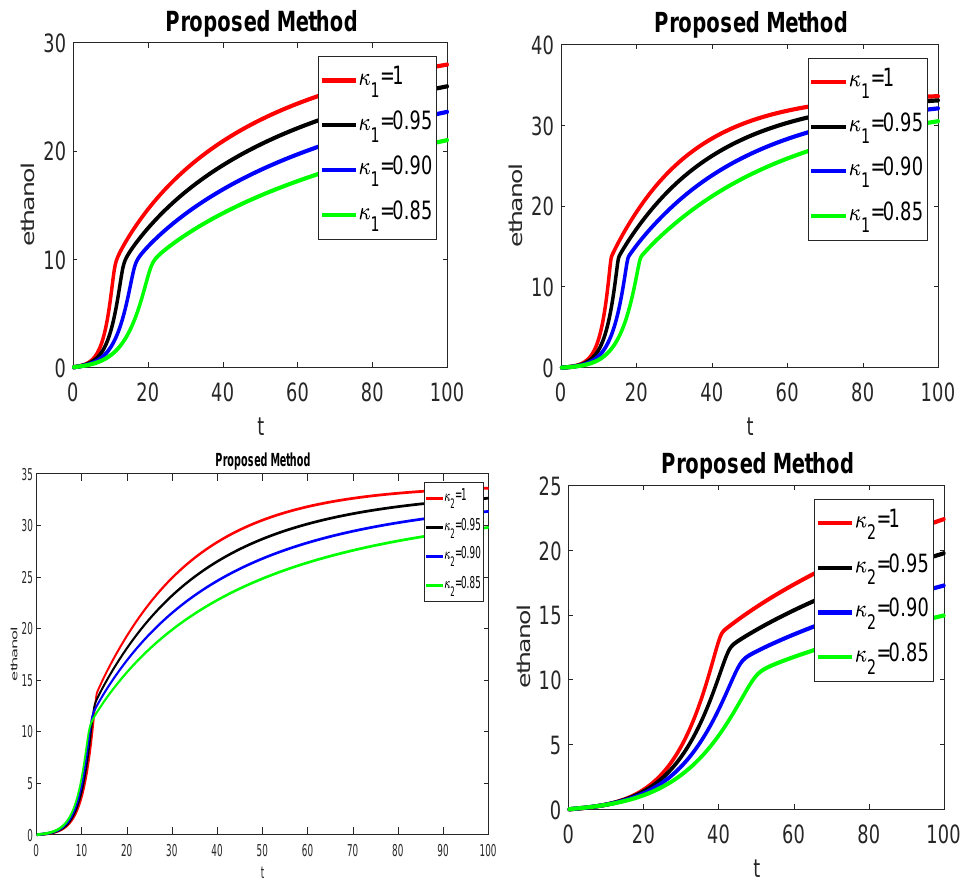
Figure 3. Graphical representation of ethanol for different values of κ 1 and κ 2